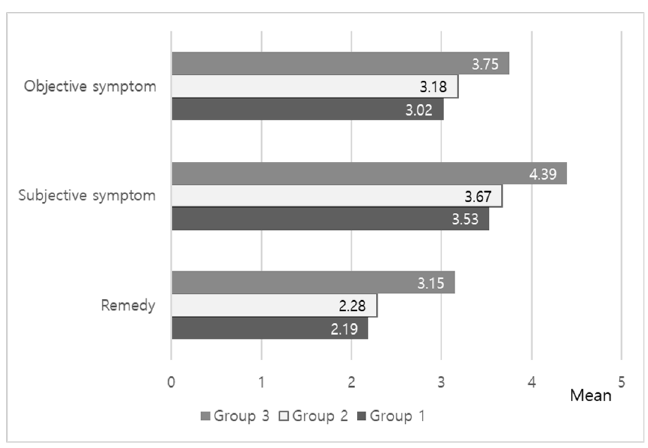
Figure 4. Physical symptoms of particulate matter experienced by residents.